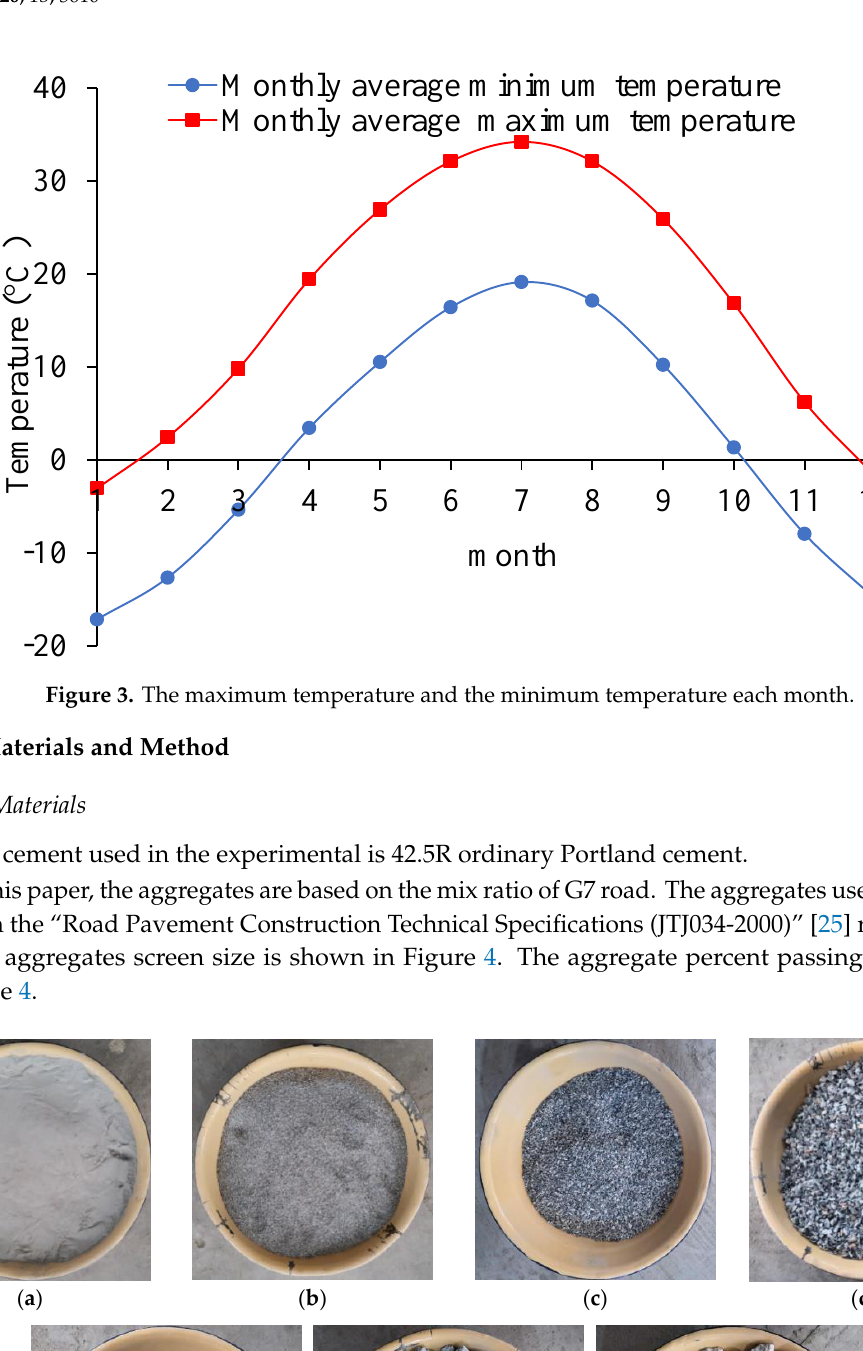
Figure 3. The maximum temperature and the minimum temperature each month.